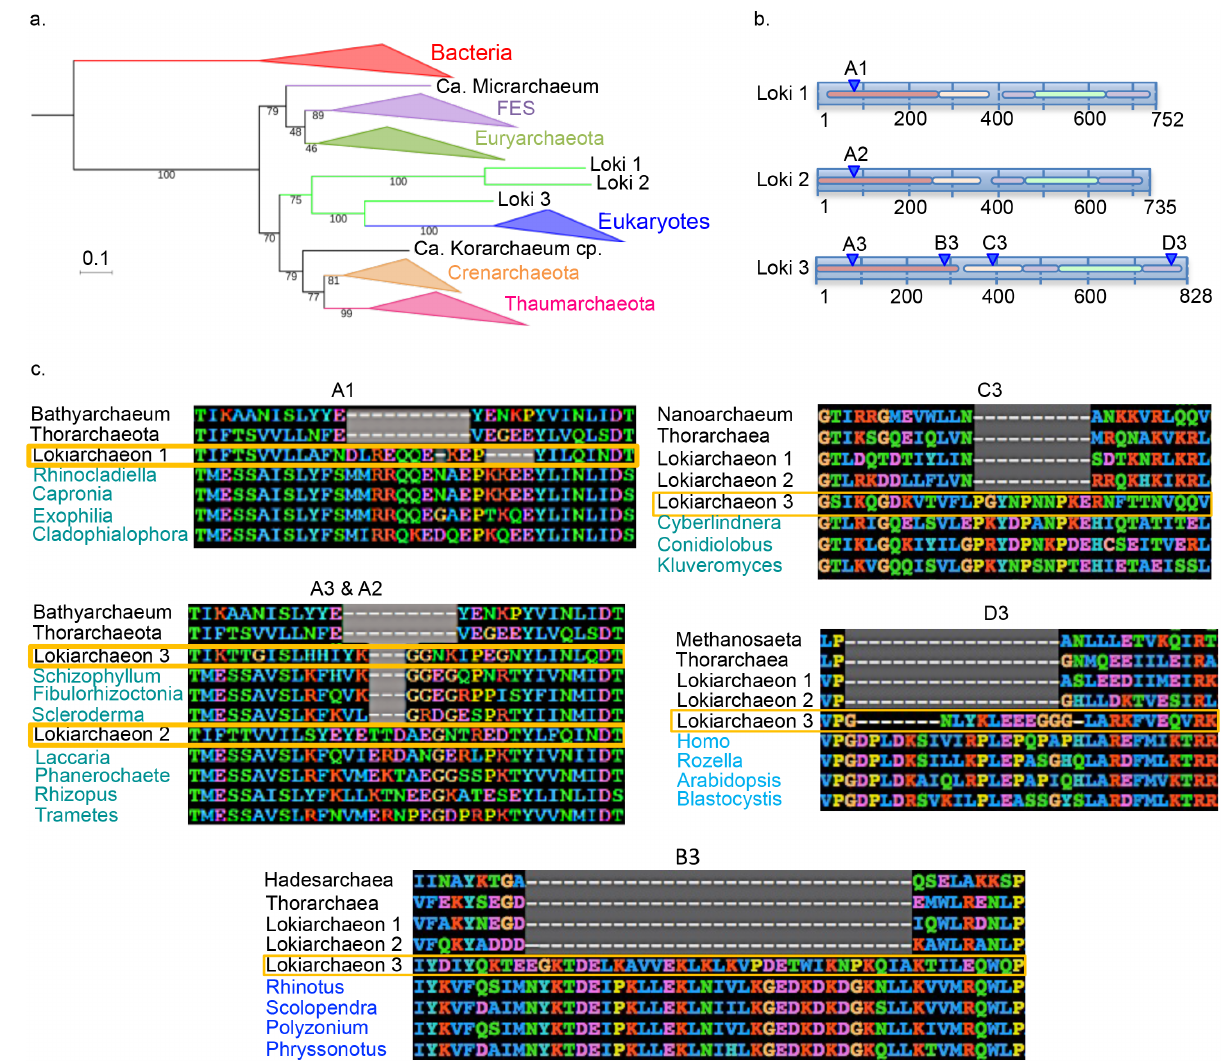
Fig 2. Eukaryotic-like insertions in the lokiarchaeal EF2 proteins. a. ML phylogenetictree of EF2 with the initial dataset (626 positions). The scale-barrepresents the averagenumber of substitutions per site. Valuesat nodes represent support calculatedby nonparametric bootstrap (out of 100). b. Schematic representations of the three lokiarchaealEF2 proteins with the five different domains indicatedby colored lines and the positionsof the specific eukaryoticinsertions indicatedbluetriangles. c. Alignments of the 6 observedinsertions of the EF2 protein (arCOG01559) are showed. Organisms’ names correspondingto Archaea and Eukarya are respectively indicatedin black and blue, and lokiarchaeal sequencesare surroundedin yellow. The A1, 2, 3 and C3 insertions are alignedwith eukaryoticRia sequences(EF2 paralog),whereasB3 and D3 are alignedwith eukaryoticEF2 and Snu5 sequences(EF2 paralog),respectively.Detailedalignments in S13–S16Figs.